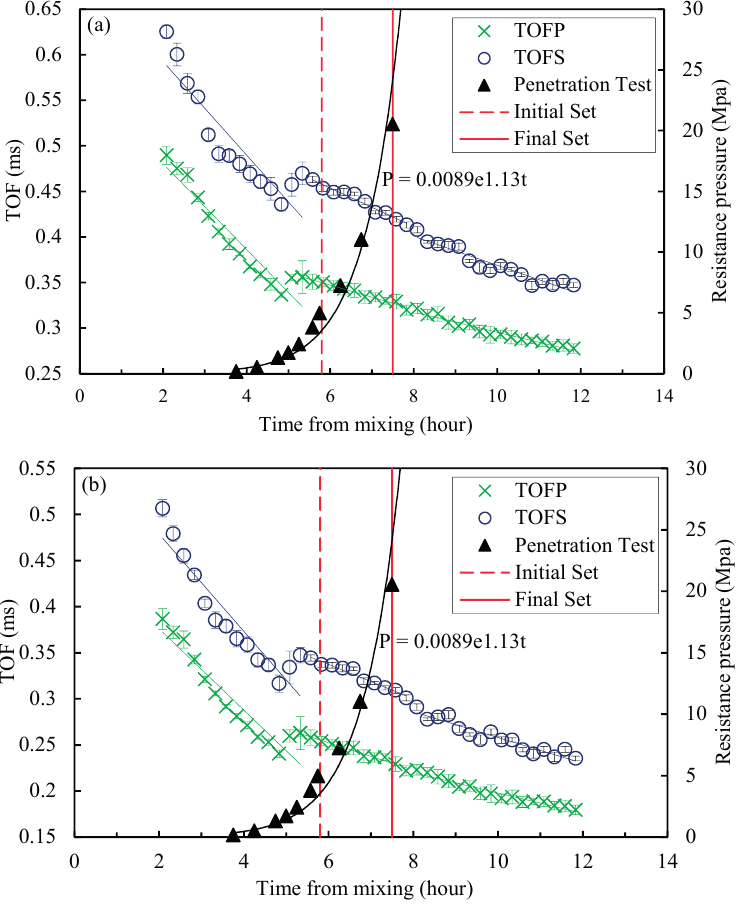
Figure 6. TOF of the PSW (TOFP) and SSW (TOFS) measured from the ( a ) 11th and ( b ) 16th bead in the HNSW transducer and penetration resistance as a function of